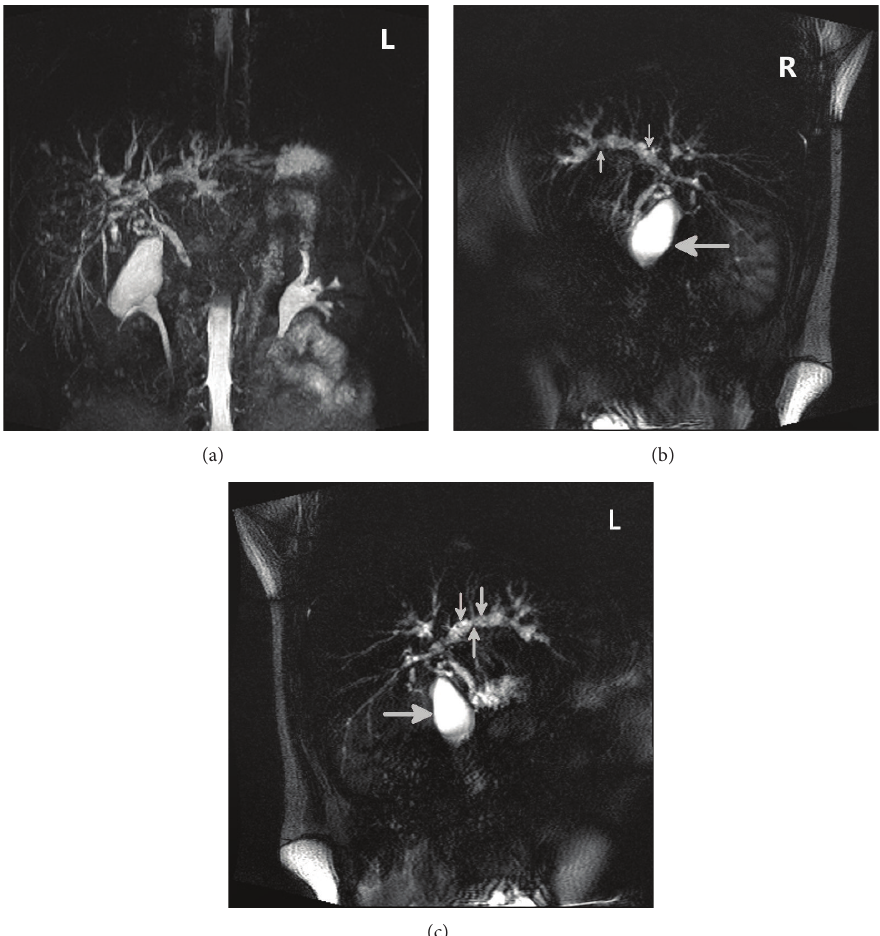
Figure 1: Irregular dilatations and constrictions of bile ducts (small arrows) diagnosed in MRCP (gall bladder, large